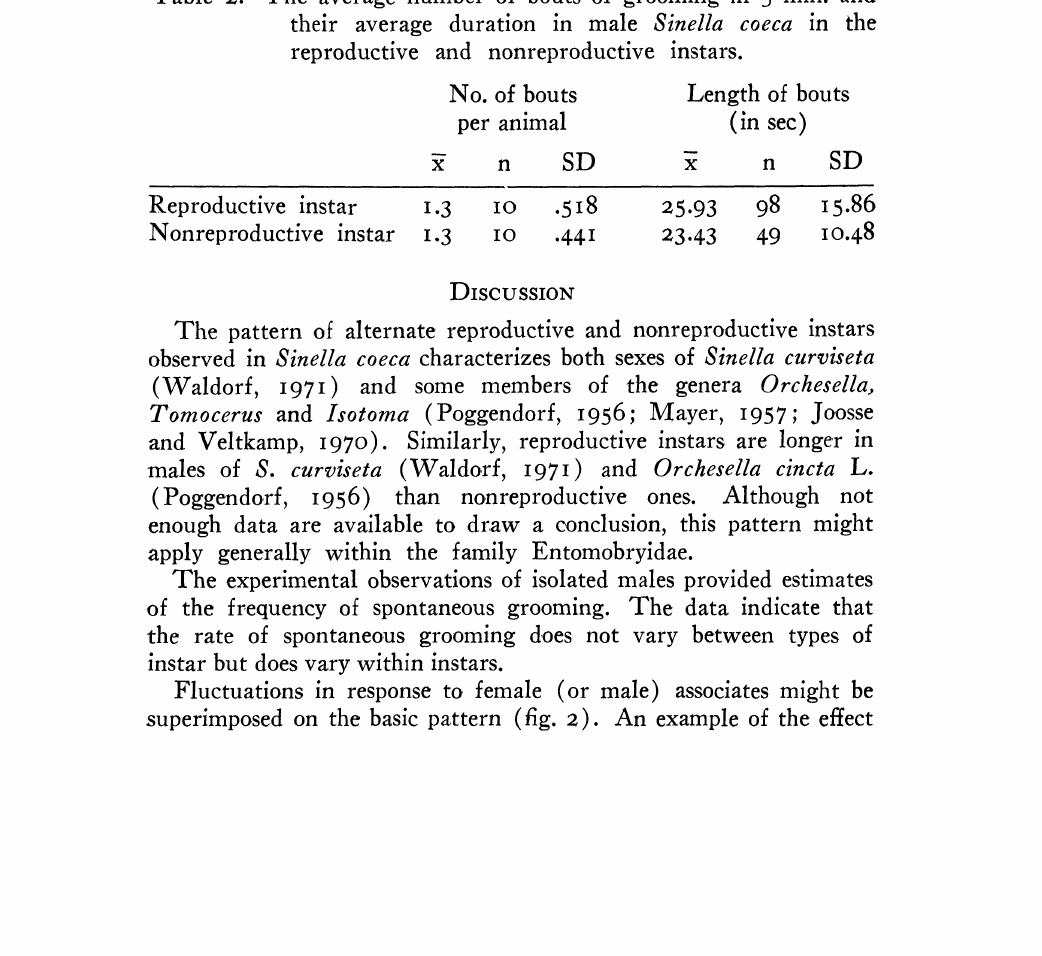
Table 2. The average number of bouts of grooming in 5 min. and their average duration in male 8inella coeca in the reproductive and nonreproductive